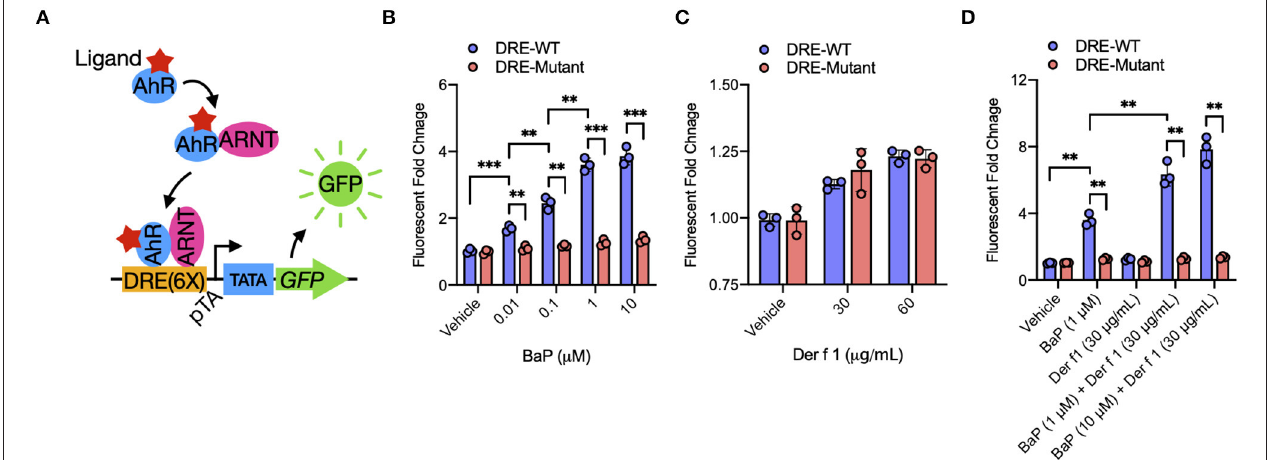
FIGURE 2 | BaP co-exposure promotes Der f 1-induced AhR activity. (A) Schematic of experimental workflow for AhR reporter plasmid. Upon ligand binding, the AhR translocates into the nucleus and heterodimerizes with AhR nuclear translocator (ARNT). The AhR/ARNT complex binds to dioxin response elements in the upstream regulatory regions of the AhR target gene Cyp1a1 and induces gene activation. (B–D) Relative AhR activity in BaP (B) , Der f 1 (C) , and BaP + Der f 1-treated 16HBECs (D) that were transfected with AhR reporter plasmid. AhR activity was assessed by green fluorescent protein quantification and expressed as fold changes relative to the control. Data represent mean ± SEM. * p < 0.05, ** p < 0.01, and *** p < 0.001.